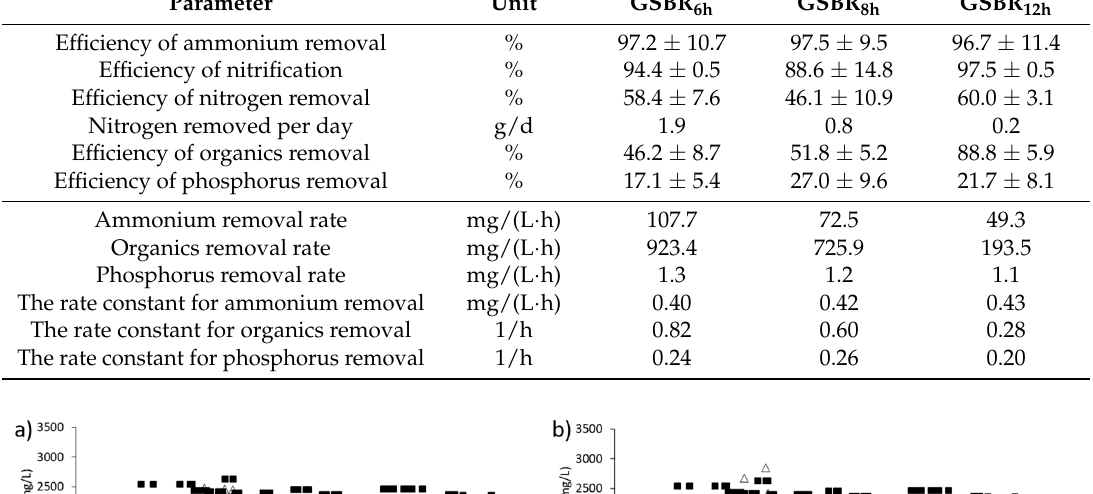
Table 1. Efficiencies and kinetics during the treatment in granular sludge batch reactors (GSBRs).